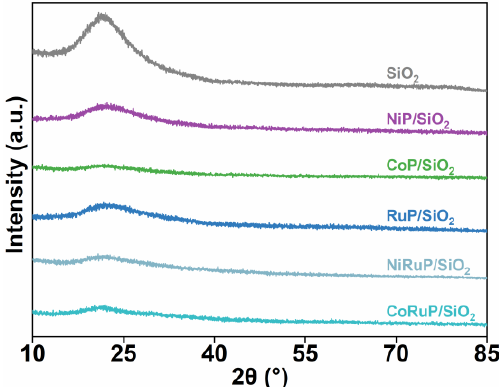
Figure 1. XRD spectra of metal phosphides.